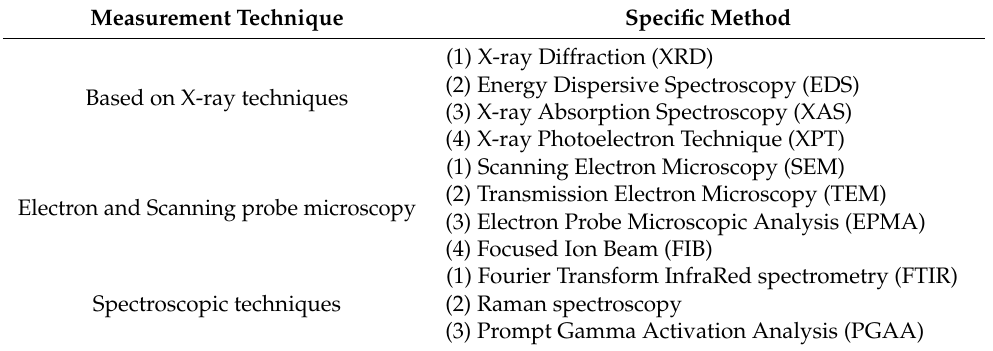
Table 1. Non-destructive testing technology (NDT